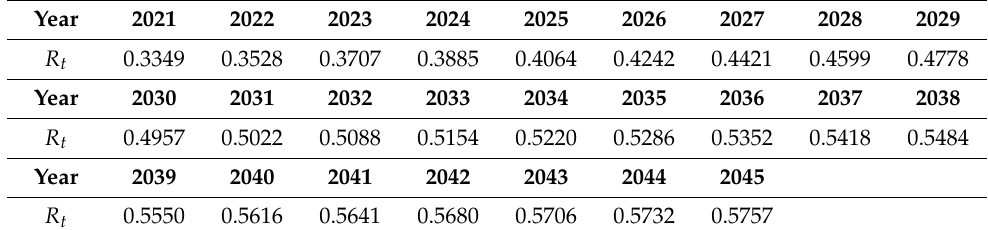
Table 7. The water rights trading price eigenvalue (WRTPE) of Helan in different years ( P E